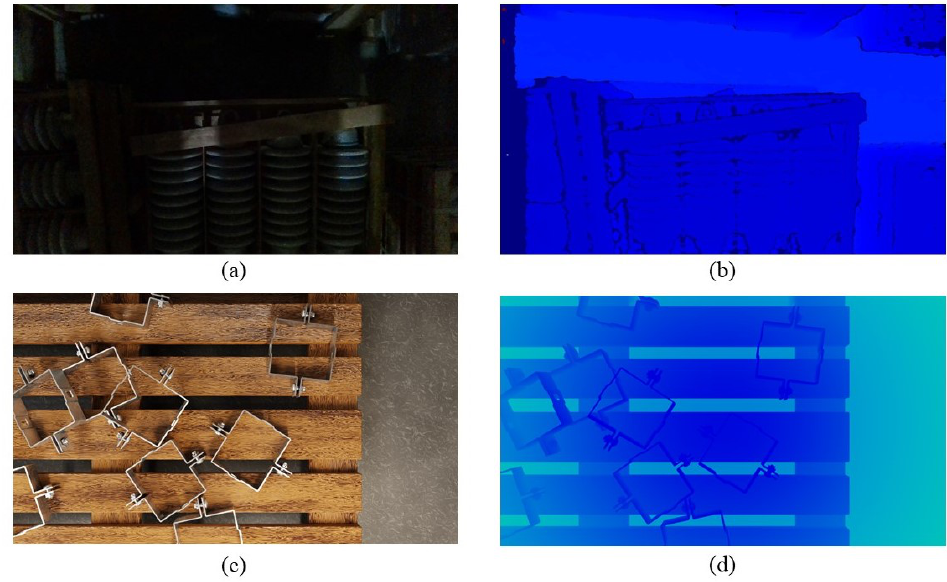
Figure 20. The four domains of the experiment: ( a ) real RGB; ( b ) real RGB-D; ( c ) synthetic RGB and ( d ) synthetic